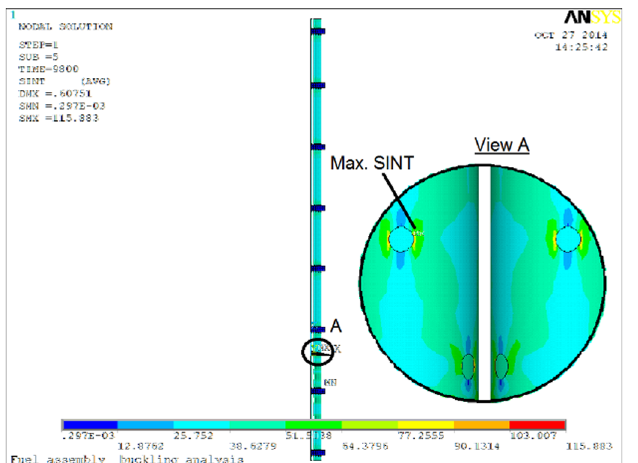
Fig. 6. Plot of nodal SINT.